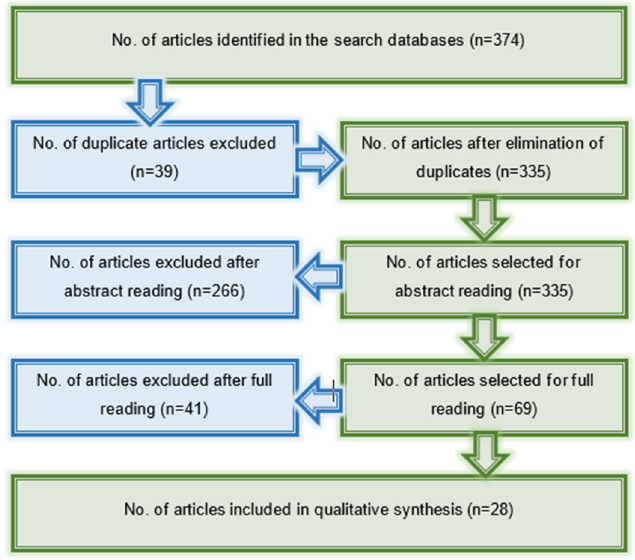
Figure 1. Flow chart of step-wise literature review process.